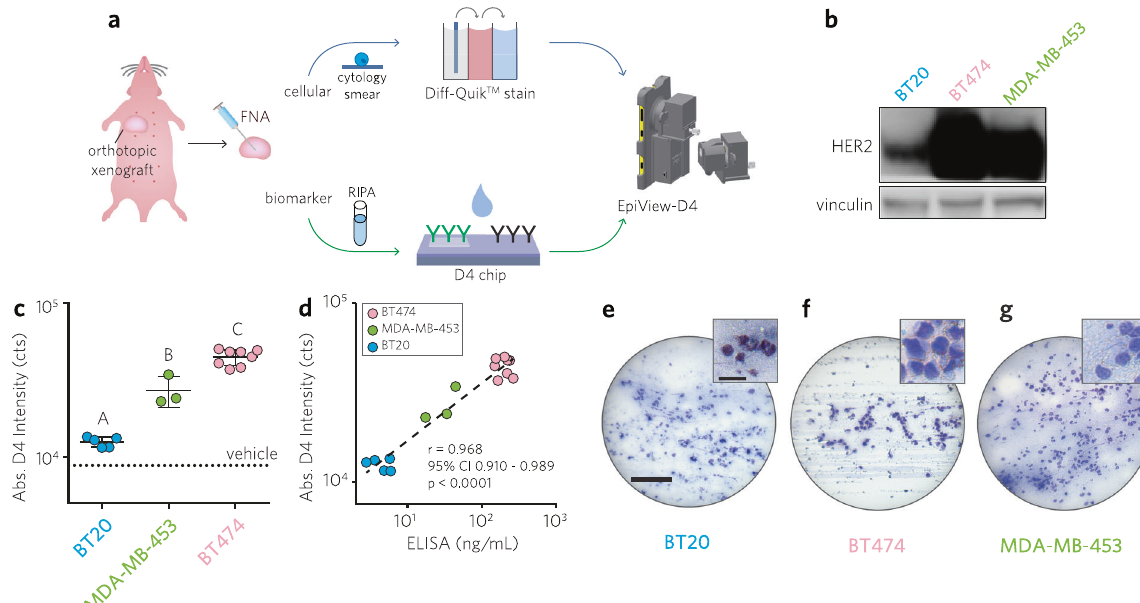
Fig. 4 Evaluation of solid tumor xenografts from nude mice orthotopically engrafted with human breast cancer cell lines with EpiView- D4. a Schematic of work fl ow. Tumor aspirates are divided into two aliquots; one aliquot from an aspirate is processed as a cytology specimen on a glass slide using a Diff-Quik TM rapid staining kit and then imaged using the bright fi eld imaging attachment (top row), The second aliquot is lysed in RIPA buffer and applied to a D4 chip and its HER2 level is quanti fi ed using the fl uorescence attachment on the EpiView-D4. b Representative western blots against HER2 for each human breast cancer cell line used for xenografting (BT20, BT474, and MDA-MB-453). Vinculin used as loading control. c Results of HER2 credentialing for 16 different solid tumor specimens from BT20, BT474, and MDA-MB-453 xenografts ( N = 5, 8, 3, respectively). Each data point represents the D4 fl uorescence intensity (average of duplicates) measured by the EpiView-D4 for individual mouse tumors, categorized by xenograft line. Also shown is the mean ± 95% CI fl uorescence intensity for each category, which mirrors the western blots shown in panel b . There was a statistically signi fi cant difference between groups as determined by one-way ANOVA (F (2, 13) = 76.10, p < 0.0001). Multiple comparison testing showed signi fi cant differences between each group (Tukey post hoc test, p ≤ 0.05). d D4 fl uorescence intensity by EpiView-D4 for each mouse tumor from f plotted against corresponding HER2 ELISA. Pearson r = 0.968, p < 0.0001, 95% CI: 0.910 – 0.989). e – g Representative LPF (main panel) and HPF (inset) images of FNA preparations for each xenograft line con fi rm malignant cytology (see Supplementary Fig. 4 for representative images with standard microscope). Scale bars for LPF and HPF images are 0.2 mm and 30 µm,